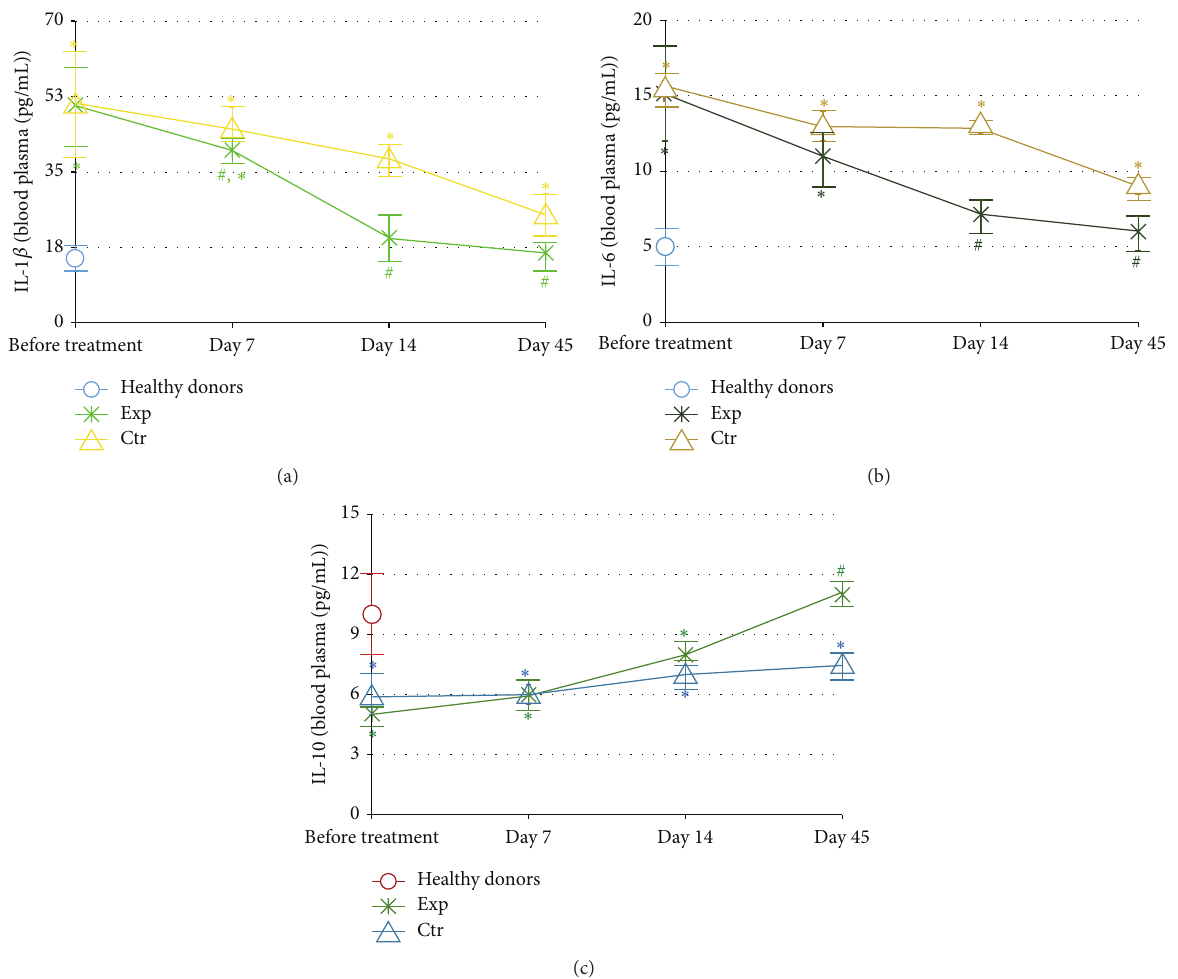
Figure 4: Dynamics of the pro- and anti-inflammatory cytokines IL-1 𝛽 (a), IL-6 (b), and IL-10 (c) in the plasma (pg/mL). The experimental group (Exp, 𝑛 = 39 ) was treated with conventional periodontal treatment plus topical daily application of fermented papaya gel into gingival pockets; the control group (Ctr, 𝑛 = 45 ) received conventional periodontal treatment for the same period of time. Healthy donors: 𝑛 = 25 . The content of cytokines in plasma was quantified by ELISA method using corresponding monoclonal antibodies. Values are represented as mean and standard deviation of the mean (SD). IL-1 𝛽 : interleukin 1 𝛽 ; IL-6: interleukin 6; and IL-10: interleukin 10. # 𝑃 < 0.05 versus analogous day of treatment in the control group. ∗ 𝑃 < 0.05 versus healthy